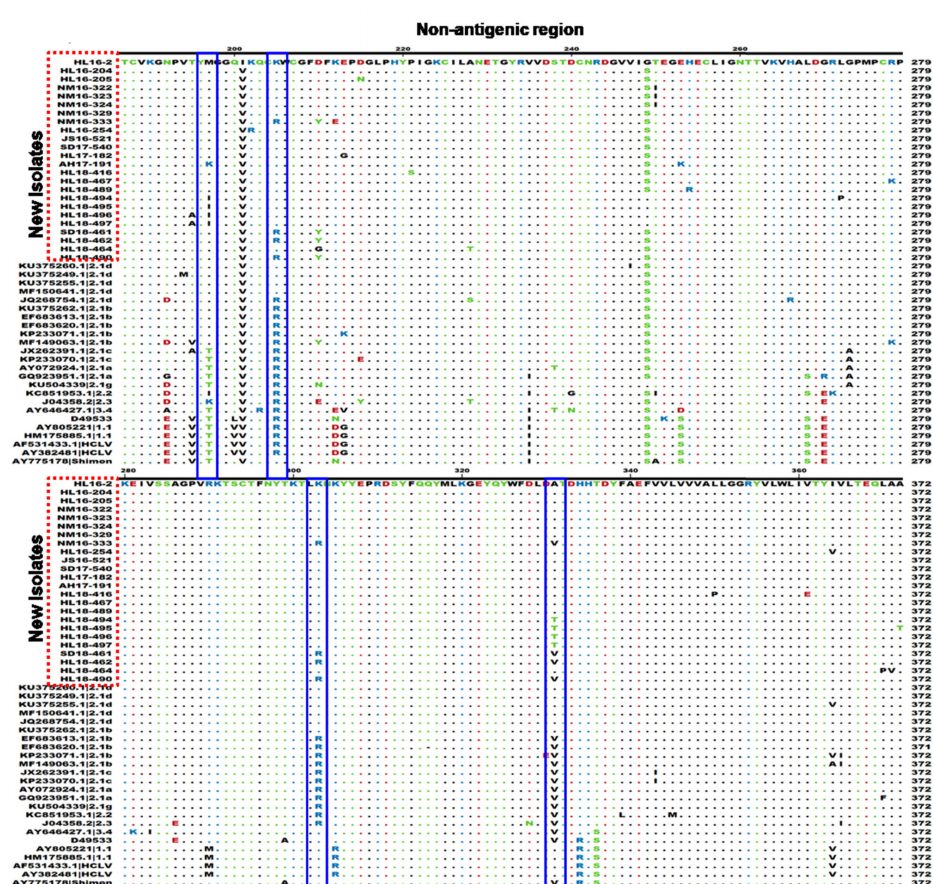
Figure 4. E2 sequence alignment of 24 new CSFV isolates. E2 amino acid sequence alignment of the 24 new CSFV strains isolated in our study, and 24 reference isolates downloaded from NCBI. The B/C domain is indicated by red line, while A/D domain is indicated by blue line and non-antigenic region is indicated by black line. Important epitope regions are also indicated by black line in antigenic